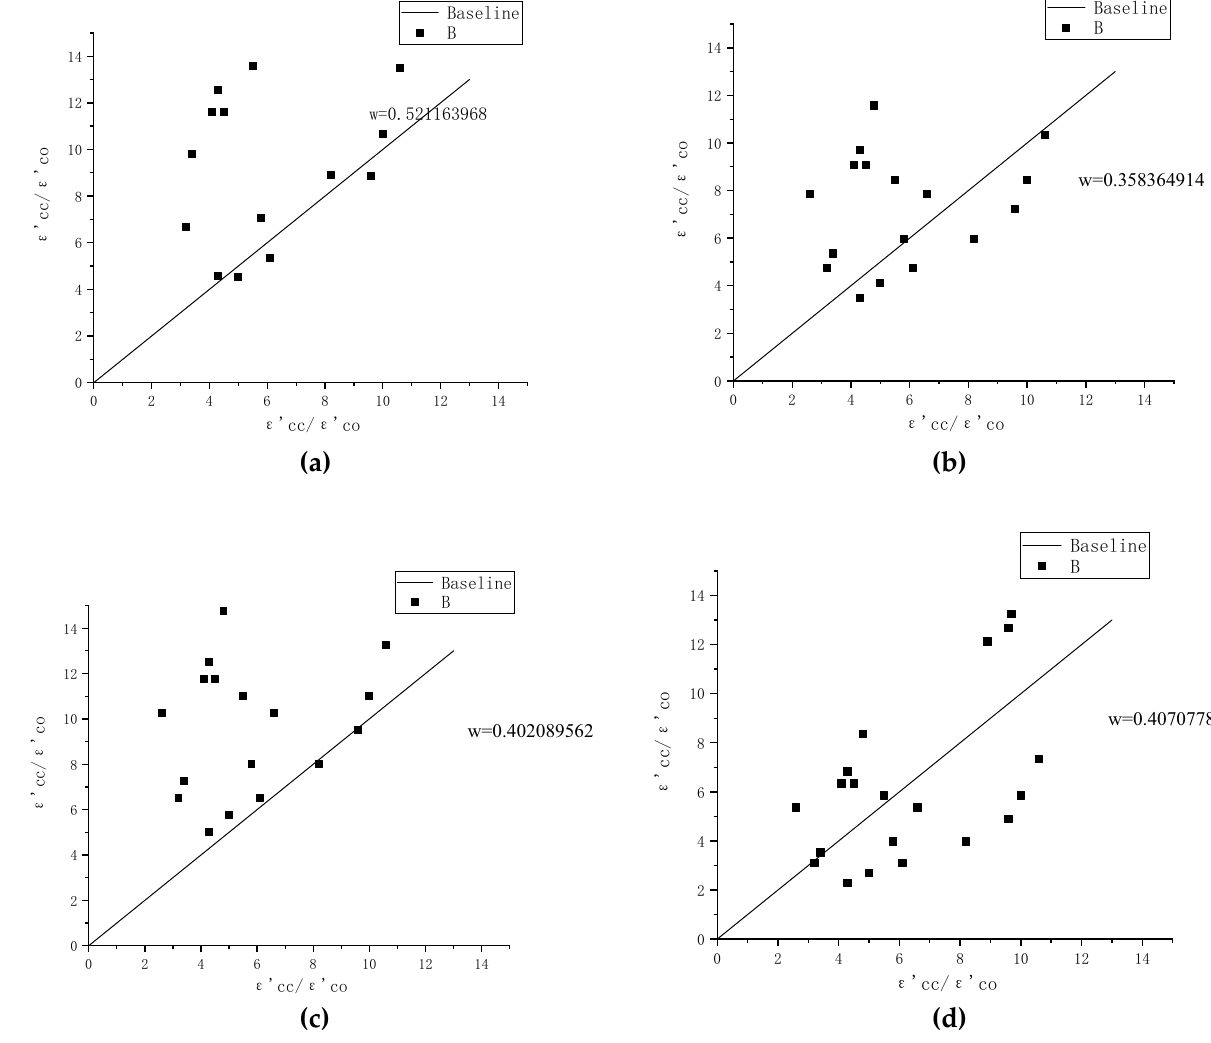
Figure 15. Error analysis of ultimate strain of FRP-confined concrete: (a) Karbhari & Gao model error analysis; (b) Toutanji model error analysis; (c) Lam & Teng model error analysis; (d) Jiang & Teng model error